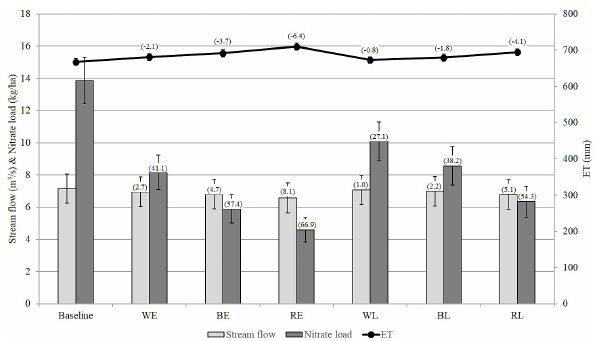
Figure 6. The 9-year average streamflow, actual evapotranspira- tion (ET), and nitrate loads at watershed scale under multiple cover crop scenarios. Note: Error bar (vertical line) represents standard deviation. The numeric value in parentheses, (), indicates reduc- tion rate (RR). RR is calculated by taking the relative difference in simulation outputs from the baseline and cover crop scenarios [RR = (Baseline − Cover crop Scenario) / Baseline].